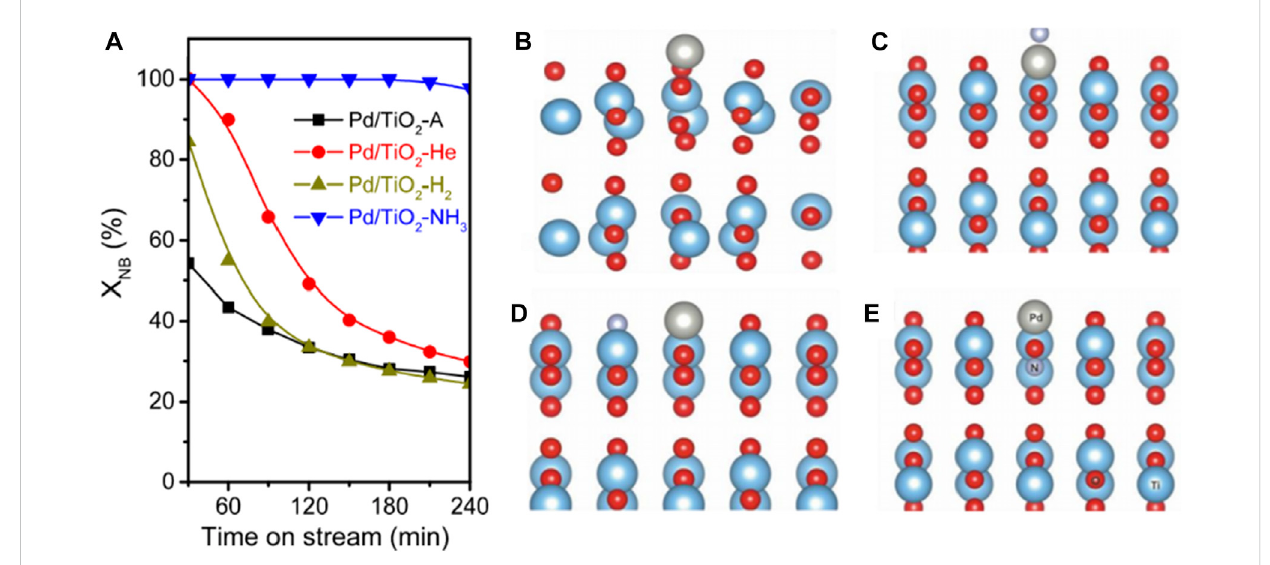
FIGURE 2 (A) TransitoryconversionofnitrobenzeneoverPd/TiO 2 catalystat160 ° C.AsideviewoftheoptimizedstructuresforPd/TiO 2 systems,withaPdatom deposited on (B) non-doped TiO 2 , (C) TiO 2 with N- adsorption on the surface, (D) TiO 2 with N-s ubstitution on the surface and (E) TiO 2 with N- substitution in the subsurface region. Spheres in red: O, light blue: Ti, gray: Pd, light purple: N, and light pink: H. Reproduced with permission from reference (Chen et al.,